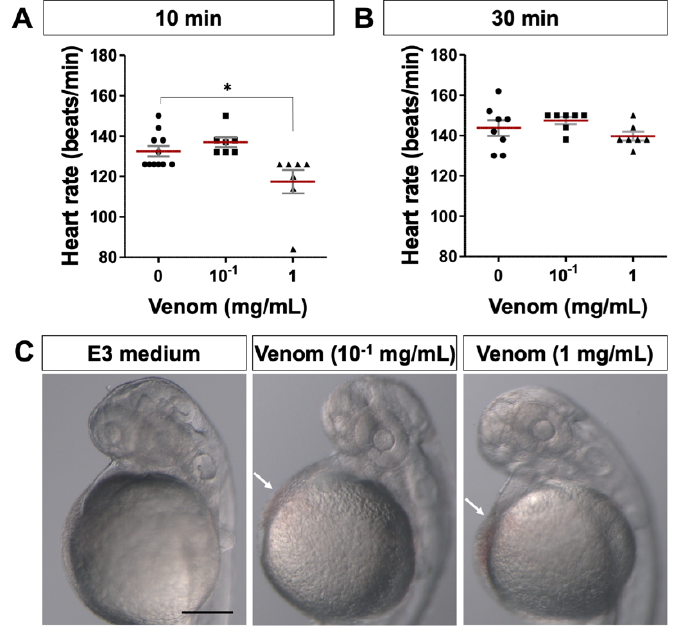
Figure 4. Cardiotoxic effects of M. bornmuelleri ’s venom on zebrafish embryos . Heart rate (beats/min) of 2-day-old zebrafish embryos measured after 10 min ( A ) and 30 min ( B ) of venom addition. E3 medium was used as the negative control. * p ≤ 0.05; at least six embryos were analyzed per condition. ( C ) Representative images of 2-day-old embryos showing dose-dependent hemorrhage (white arrows) 6 hrs after venom addition. E3 medium was used as the negative control, showing no sign of hemorrhage. Scale bar: 200 µm.